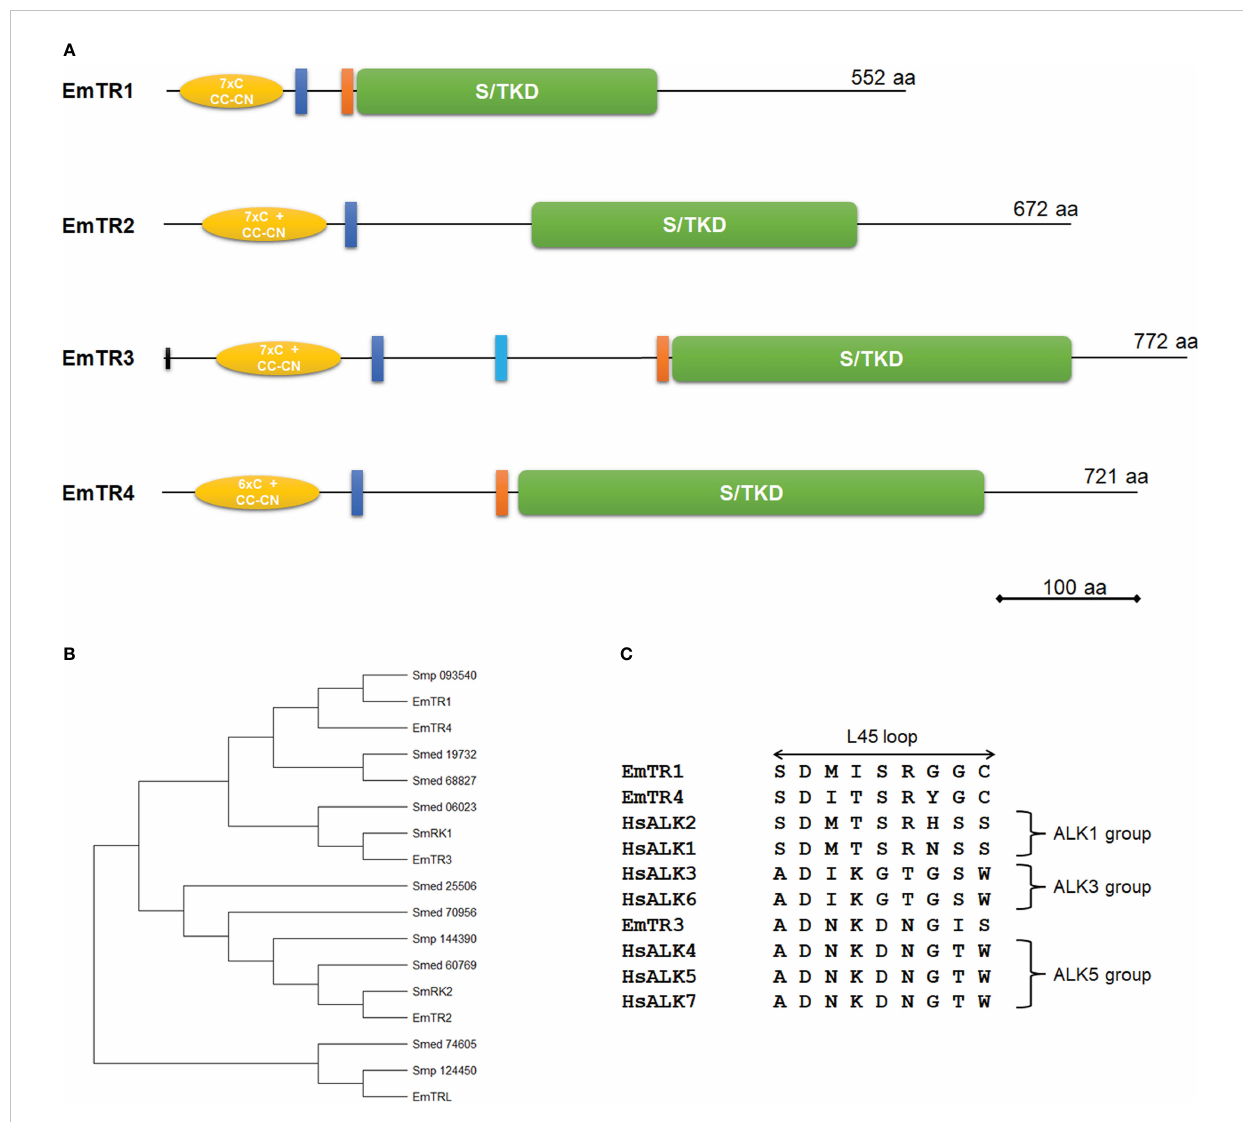
FIGURE 1 Structure and sequence features of E. multilocularis TGF b /BMP receptors. (A) Receptor domain structures. Displayed are structurally important domains for all four characterized TGF b /BMP receptors. Indicated are the serine/threonine kinase domain (green, S/TKD), the extracellular Cys-rich regions (yellow, with numbers of cysteine residues and CC-CN box), the transmembrane domain (dark blue), and the GS box (orange). The second predicted transmembrane domain for EmTR3 is indicated in light blue. Receptor sizes are indicated to the right. Bar indicates 100 amino acids. (B) Phylogenetic tree of different fl atworm TGF b /BMP receptors. Phylogenetic tree has been performed using MEGA software (version 11), applying the Maximum Likelihood method. Indicated are all characterized Echinococcus receptors as well as proteins from S. mansoni (Smp) and S. mediterranea (Smed) according to accession numbers as referenced in Table S1. (C) Amino acid sequence comparison of L45 loop regions. Displayed are the L45 loop sequences of the Echinococcus type I receptors EmTR1, EmTR3, and EmTR4 and human TGF b /BMP type I receptors (for accession numbers see Table S1). Receptor groups are indicated to the